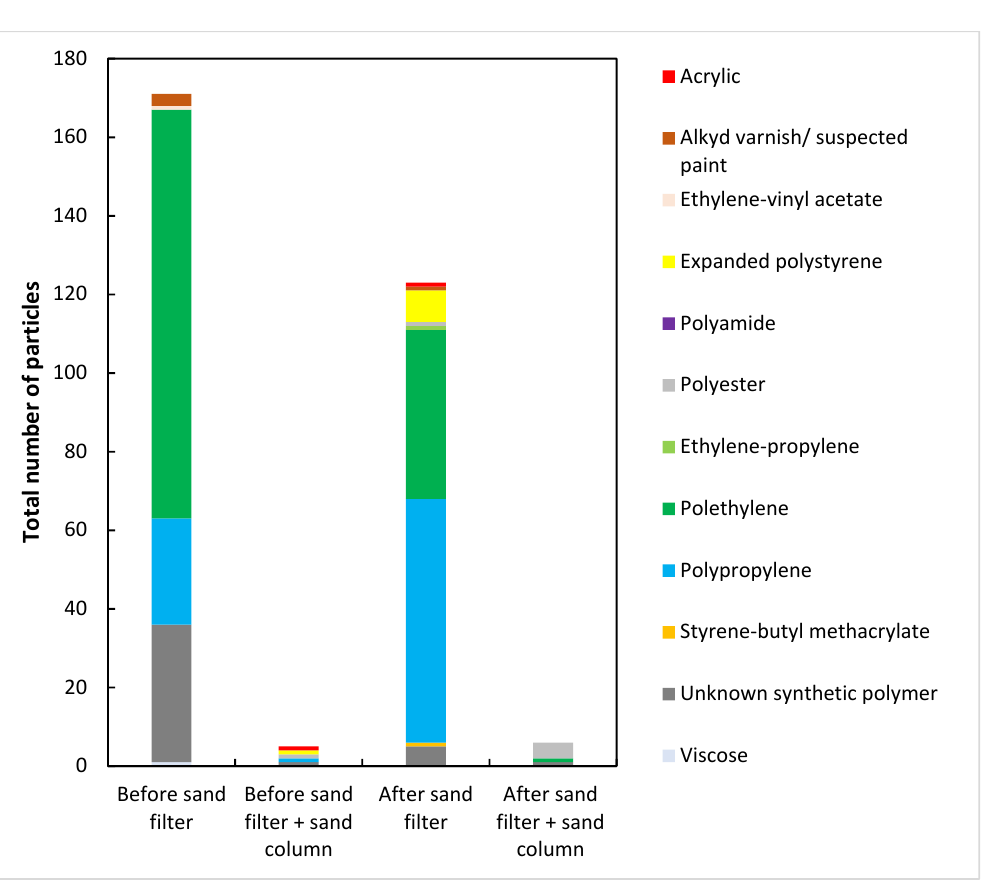
Figure 5. Distribution of different polymers for both types of wastewater, before and after the sand- filter .